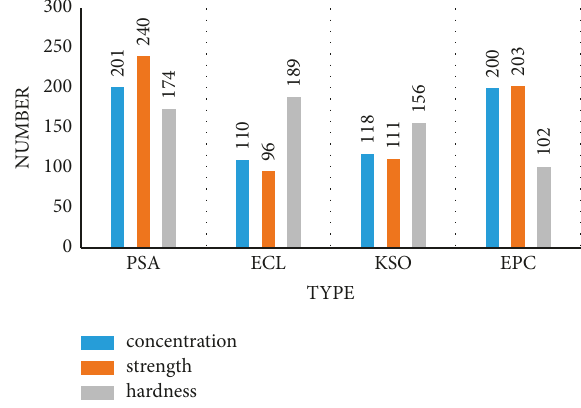
Figure 4: Graph of pH concentration changes.